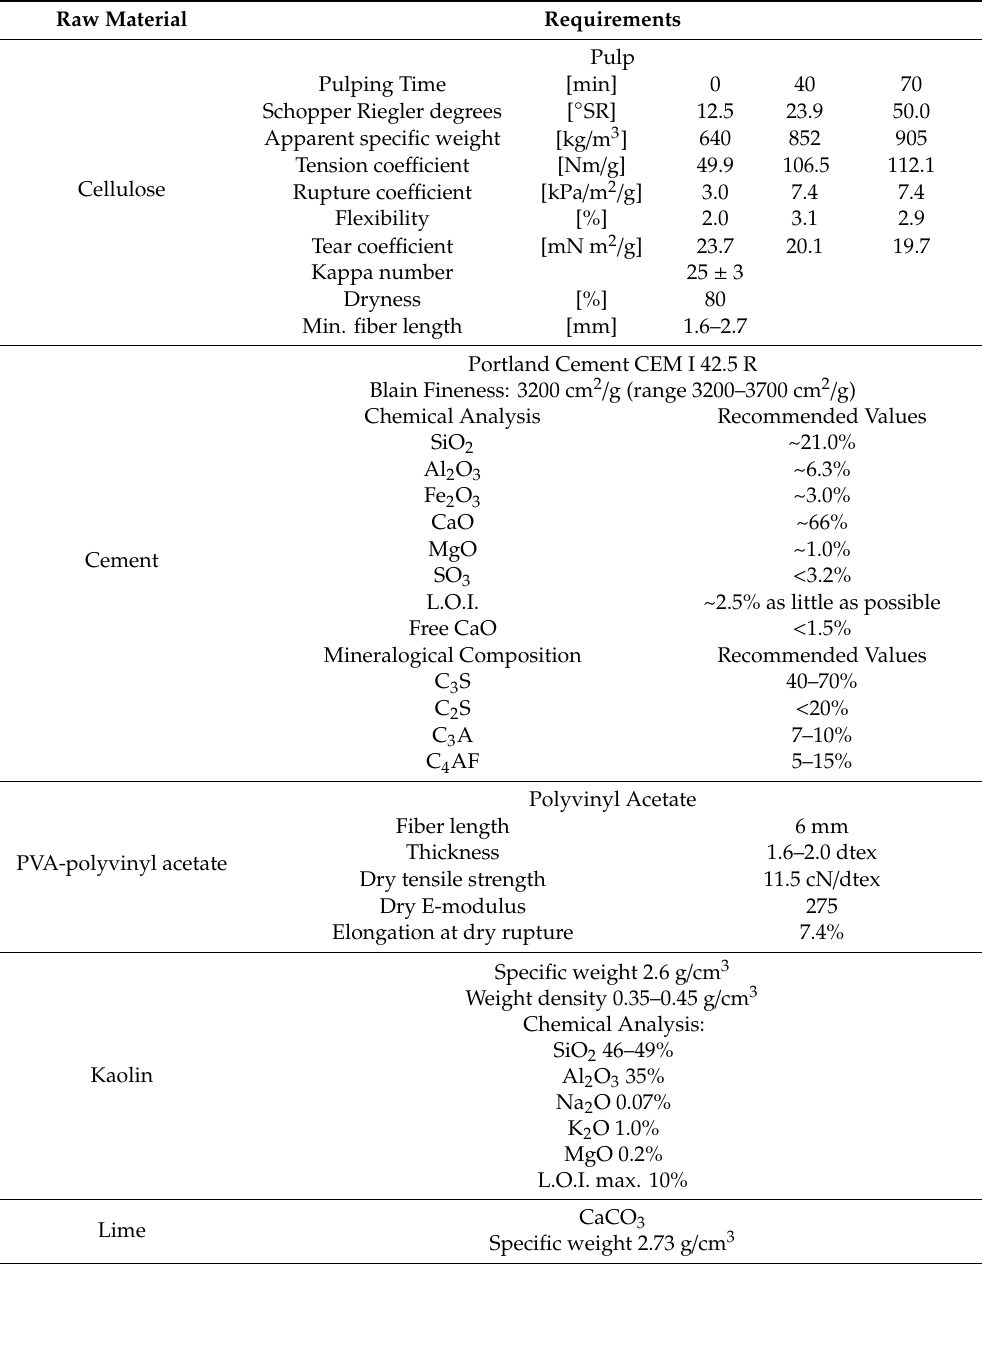
Table 2. Requirements for selected raw materials used in production of fiber cement boards